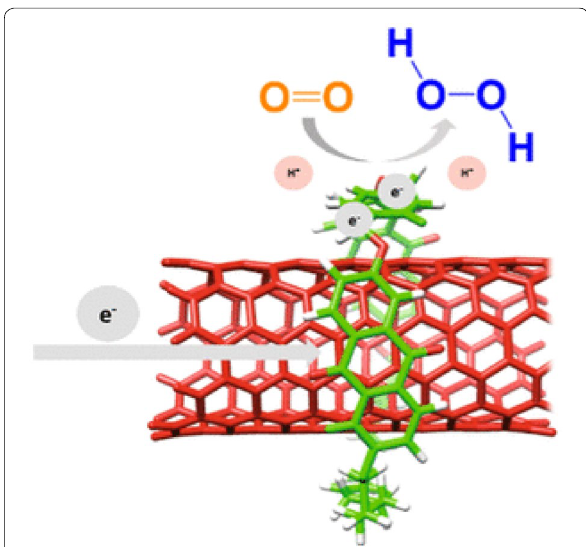
Fig. 9 Electrocatalytic O 2 reduction with a mechanically interlocked CNT with an anthraquinone macrocycle. Copyright permission from ACS